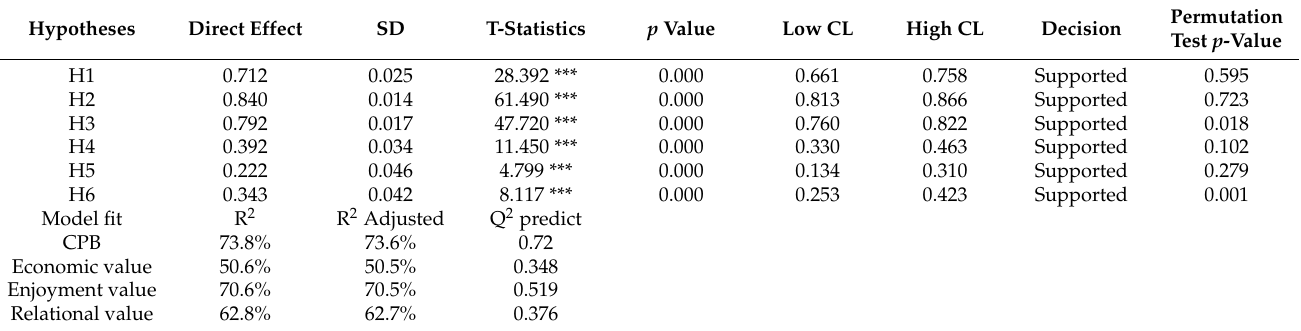
Table 4. Results of research hypotheses and model